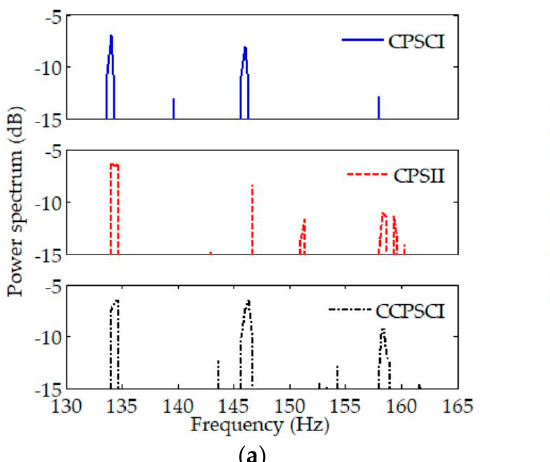
Table 2. Averages of discrete spectra in simulation.